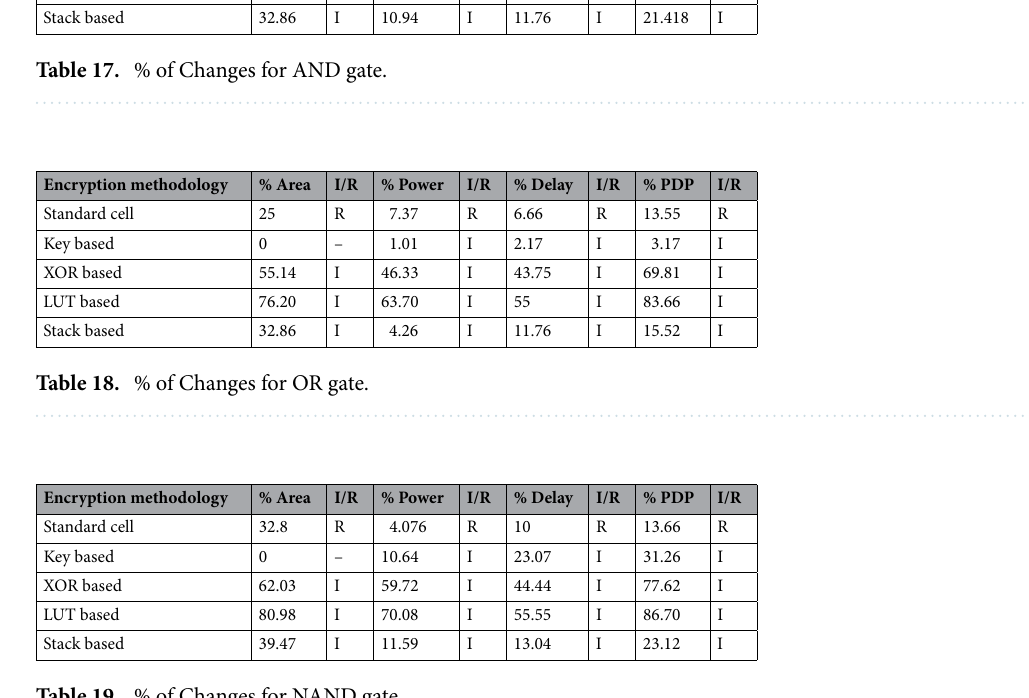
Table 19. % of Changes for NAND gate.